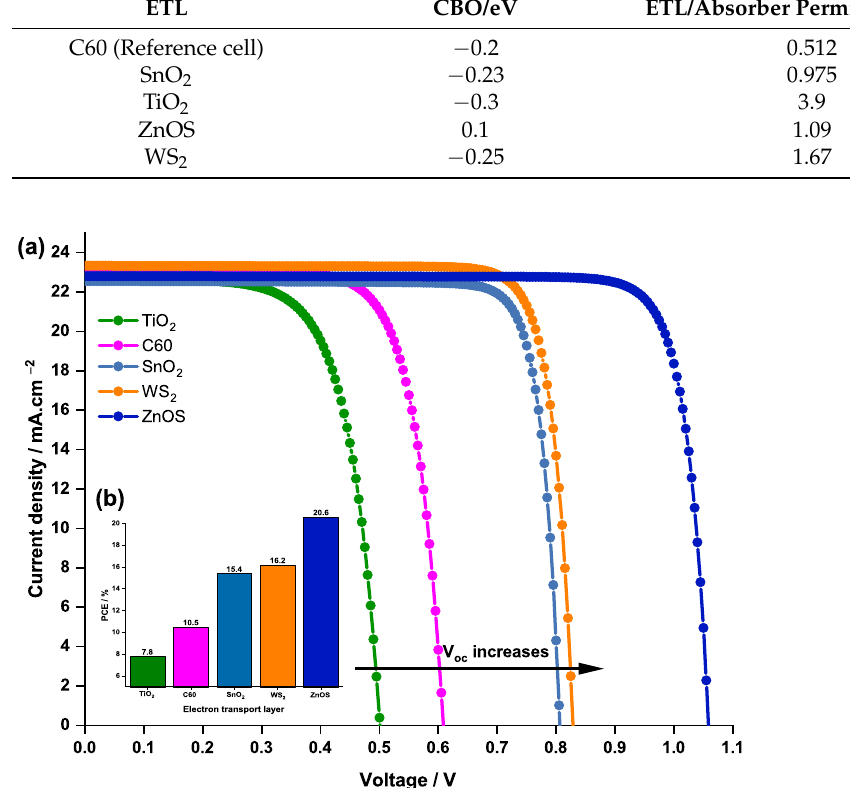
Figure 9. Effect of the ETL material on ( a ) the current density—voltage characteristics of the PSC and ( b ) the